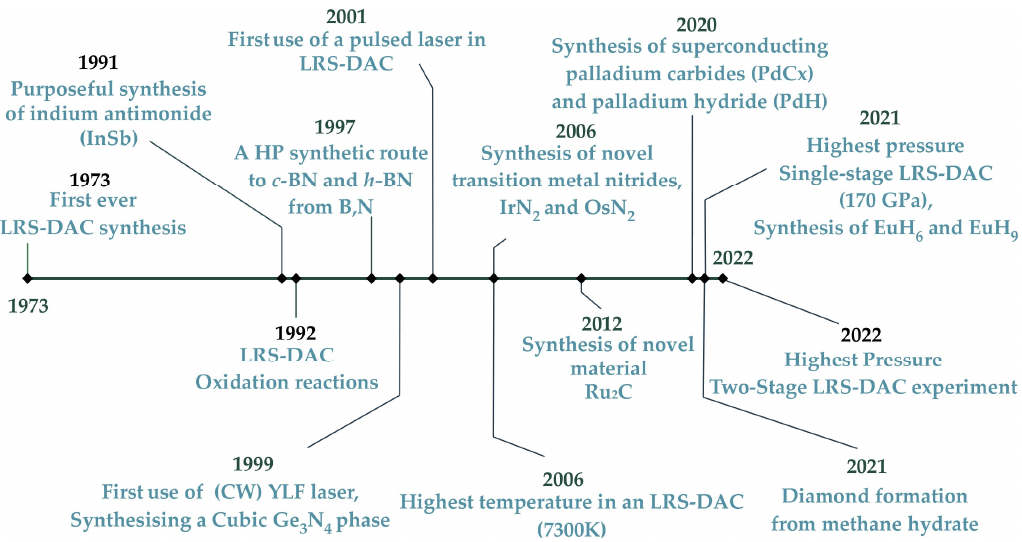
Figure 11. Chronology of key LRS-DAC developmental events, from 1973 to 2022.